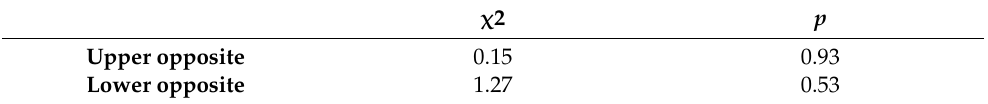
Table 4. Pearson’s chi-squared test results of jump shot precision